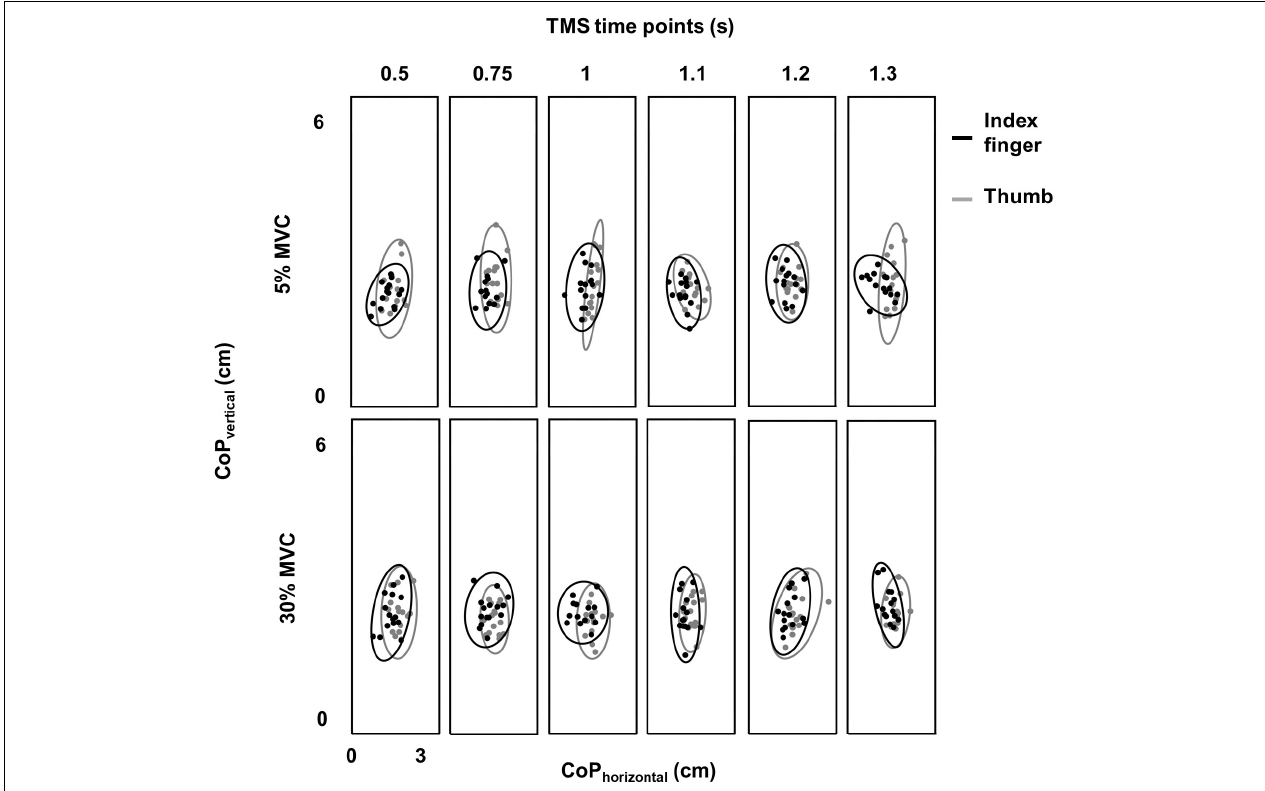
FIGURE 3 | Variability in digit placement. Center of pressure (CoP) for thumb (gray) and index finger (black) for each TMS time point at 30% and 5% of force from a representative subject. Vertical and horizontal components of thumb and index finger CoP are shown on the same plot. Ellipse contained CoP points within 95% confidence interval in each task and at each TMS time point.